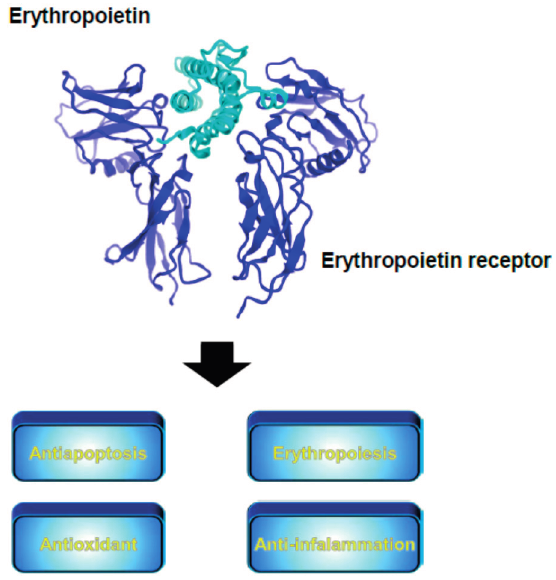
Figure 3. Crystal structure of erythropoietin ( aqua ) and erythropoietin receptor ( blue